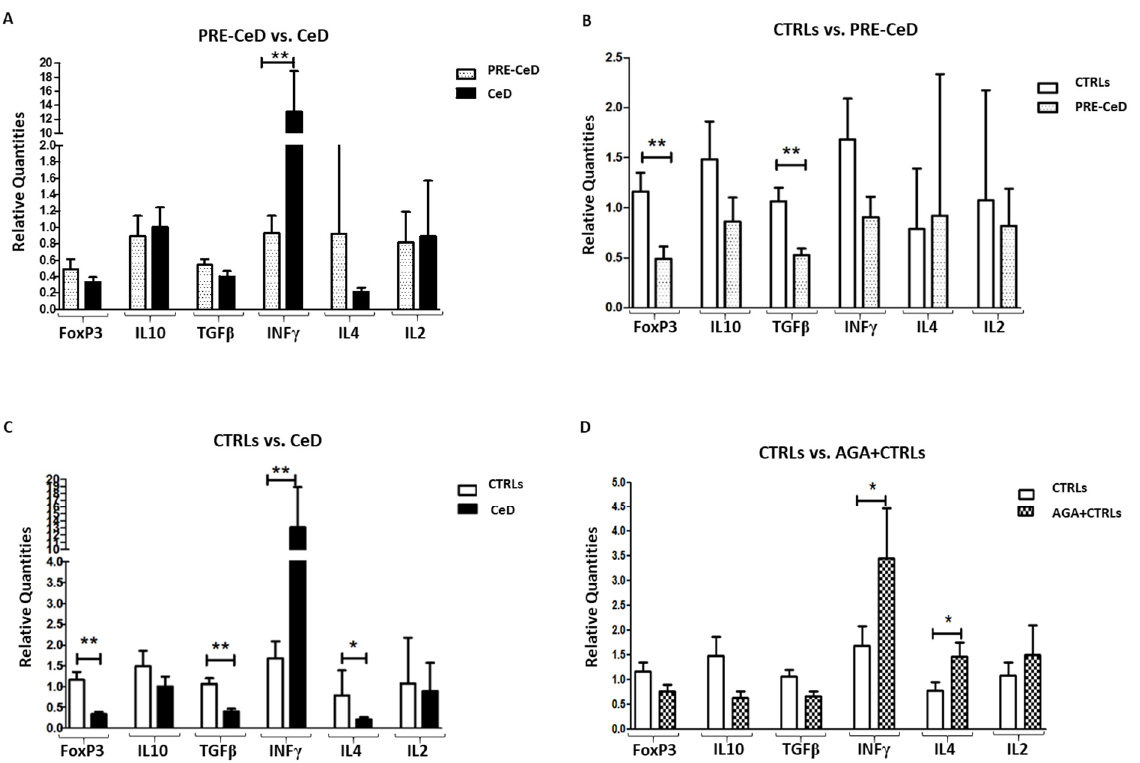
Figure 2. Relative Quantities (RQs) of the expression of selected cytokine genes. Gene expression of FoxP3, IL10, TGF β , INF γ , IL4 and IL2 was observed in 67 blood samples and analyzed according to Minimum Information for Publication of Quantitative Real-Time PCR Experiments (MIQE) guidelines. ( A ) Gene expression comparison between patients before the diagnosis (PRE-CeD, dotted histograms) versus active celiacs (CeD, black histograms), ( B ) PRE-CeD (dotted histograms) vs. controls (CTRLs, white histograms), ( C ) CTRLs (white histograms) vs. active CeD (black histograms), ( D ) CTRLs (white histograms) vs. controls with early production of AGAs (AGA+CTRLs, crossed histograms). Data are shown as medians and confidence intervals of all experiments. Comparison between groups was performed by Wilcoxon Rank-Sum Test, with a p < 0.05 considered statistically significant and labeled with asterisks: * = p < 0.05, ** = p < 0.01. 2.5. Multivariate Analysis to Predict Early Antibody Production and Later Development of CeD Since the analyzed biomarkers are correlated, we aimed to find the best profile for each study group in order to distinguish children who develop a tolerogenic antibody response from those who progress to the full-blown disease. As summarized in Table 2, early AGA production in CTRLs is best predicted by the combination of IL4, FoxP3 and INF γ gene expression and, in addition, by the presence of the serum cytokine IL17A, with the correct discrimination of 85% CTRLs from AGA+CTRLs. PRE-CeD children are well (93%) differentiated from healthy CTRLs, regardless of the serum antibody production, by the presence of serum cytokines (IL2, IL4, IL12, INF γ , IL17A and IL10), along with the expression of IL10, IL4 and INF γ . This difference is similar to that observed between children with active CeD and CTRLs, so the hypothesis that PRE-CeD children have an inflammatory profile activated before the production of specific antibodies (DGP and anti- tTG) and the development of flat mucosa is supported. All PRE-CeD children are discriminated from AGA+CTRLs by IL17A and IL10 cytokines together with INF γ , FoxP3 and IL4 gene expression. Most inflammatory biomarkers are equally increased in both PRE-CeD and CeD groups; nevertheless, 94% of PRE-CeD children are correctly differentiated from those with full-blown CeD by a model that includes INF γ and TGF β gene expression together with TNF α and IL1 β serum cytokines.